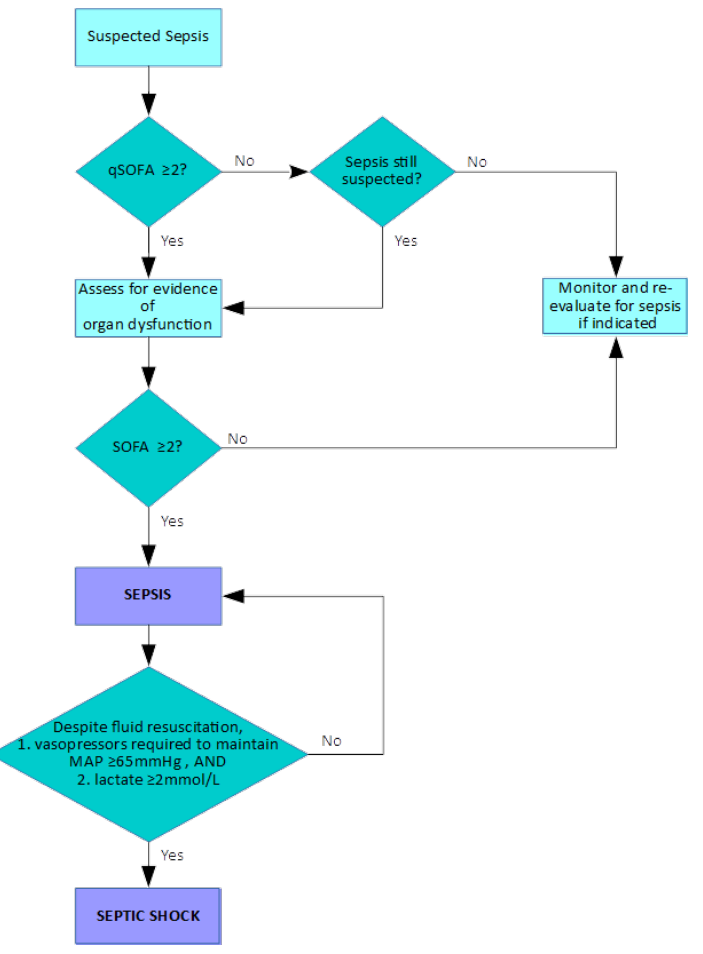
Figure 1. Clinical criteria for identifying sepsis and septic shock, adapted from Singer et al. [22]. qSOFA: Quick Sequential Organ Failure Assessment; SOFA: Sequential Organ Failure Assessment. Table 3. “Sepsis-3” definitions and identifying features, adapted from Singer et al.